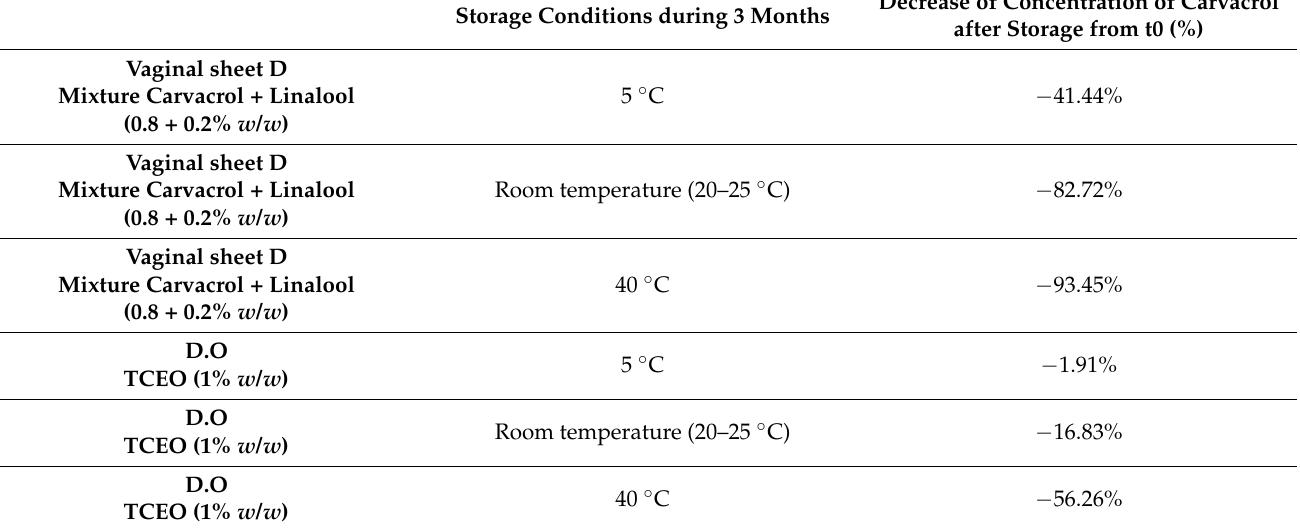
Table 4. Evaluation of TCEO content (represented by carvacrol component) after 3 months of storage at 40 ◦ C, 5 ◦ C and room temperature (20–25 ◦ C) for vaginal sheet D (preferred